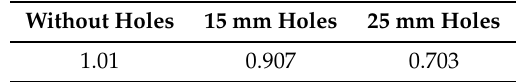
Table 10. Total weight of each 40 mm thick liner made of AC216 [kg].